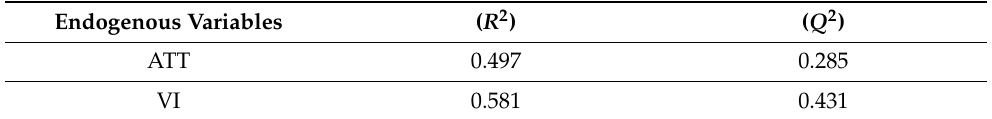
Table 4. Model goodness of fit R2 and Q2.